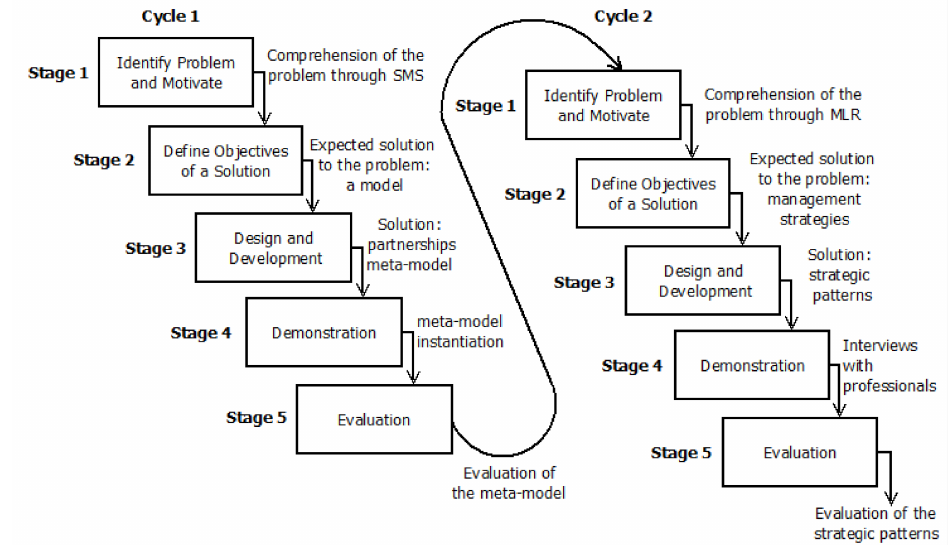
Figure 1. Stages executed of Design Science Research process and respective